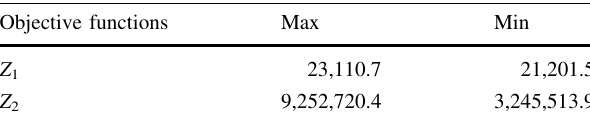
Table 5 The range of the objective function values Objective functions